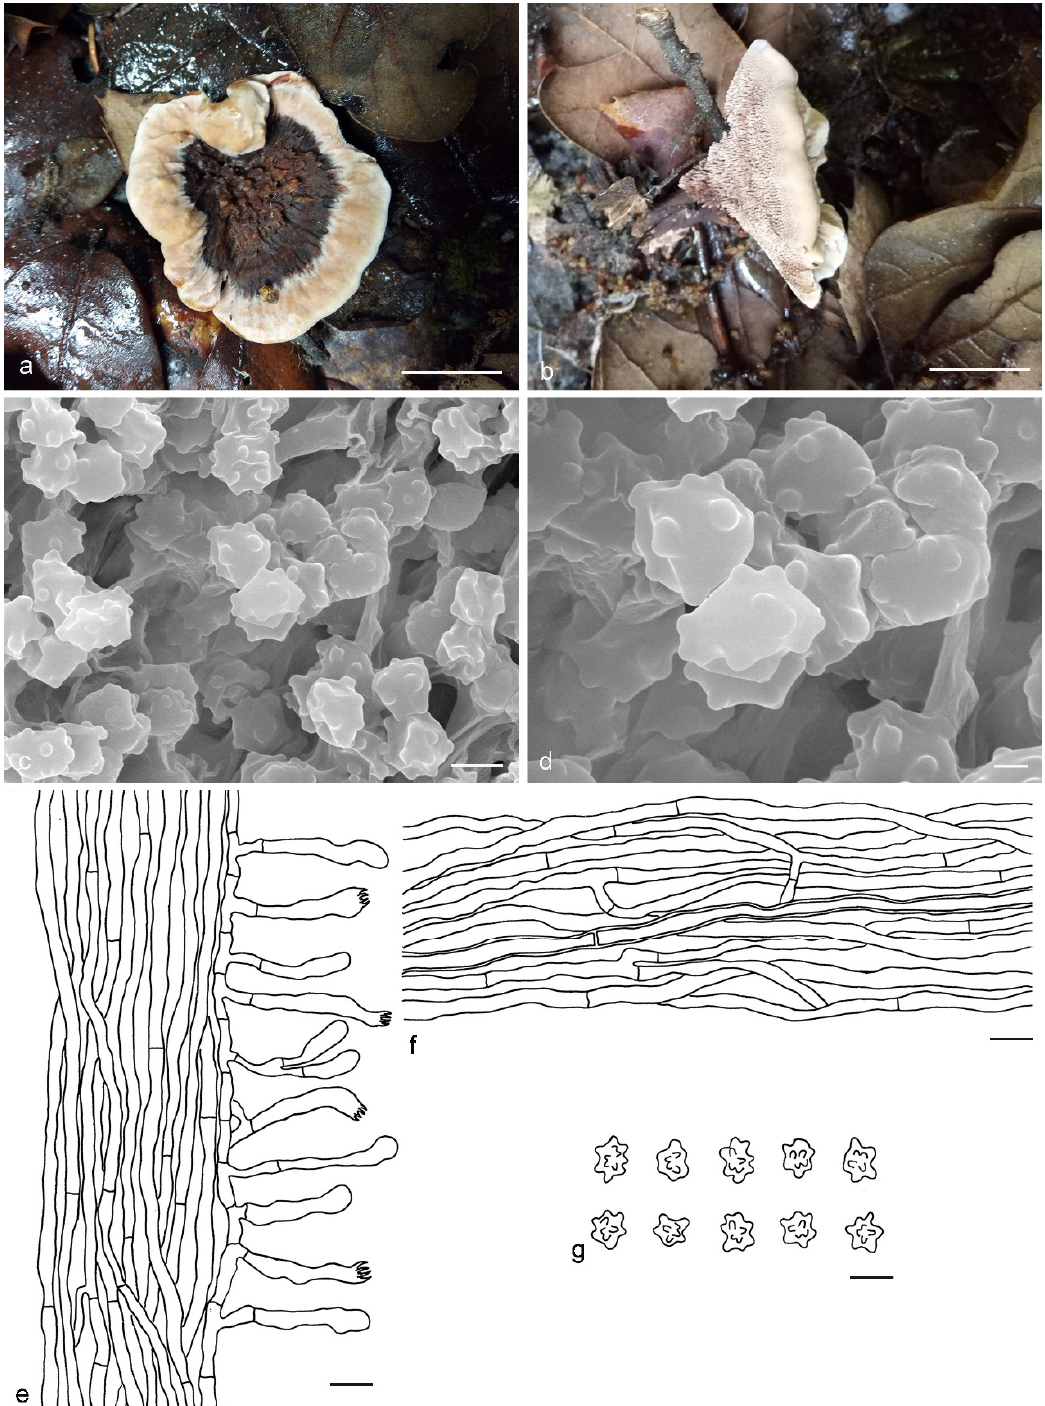
Figure 9. Hydnellum bomiense. ( a , b ): Basidiocarps; ( c , d ): SEM of basidiospores; ( e – g ): Microscopic structures (drawn from IFP 019382); ( e ): Section of hymenophore trama with basidia; ( f ): Hyphae from pileus context; ( g ): Basidiospores. —Scale bars: ( a , b ) = 1 cm; ( c ) = 3 μm; (d) = 1 μm; ( e , f ) = 10 μm; ( g ) = 5 μm.